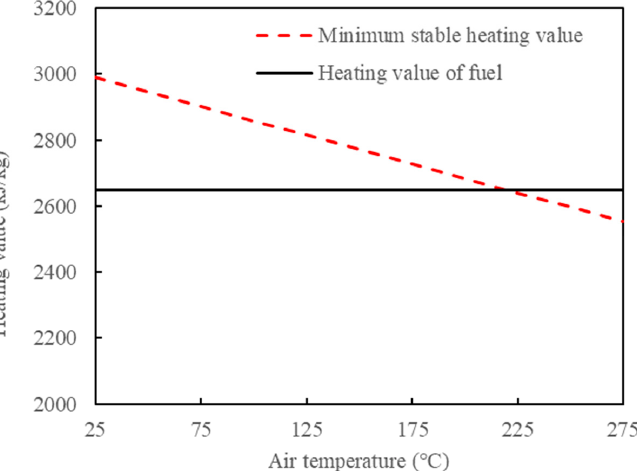
Figure 9. Changes in fuel heating value and its minimum steady burning calorific value with air